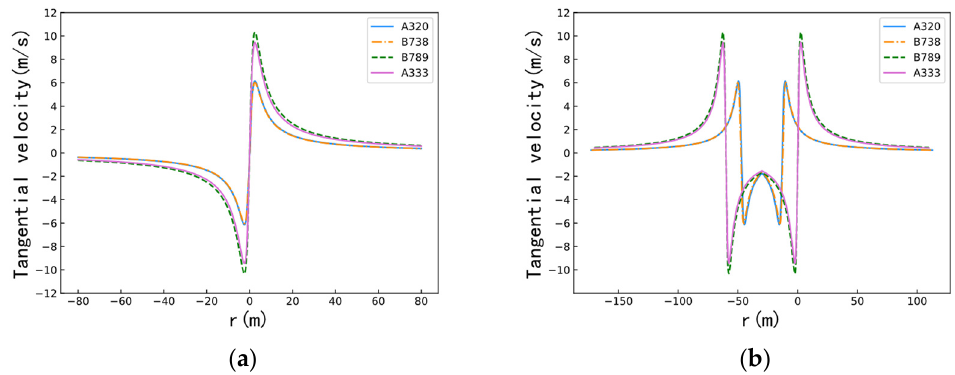
Figure 1. Induced velocities of different aircrafts at 174.95 kts. ( a ) Single vortex. ( b ) Twin